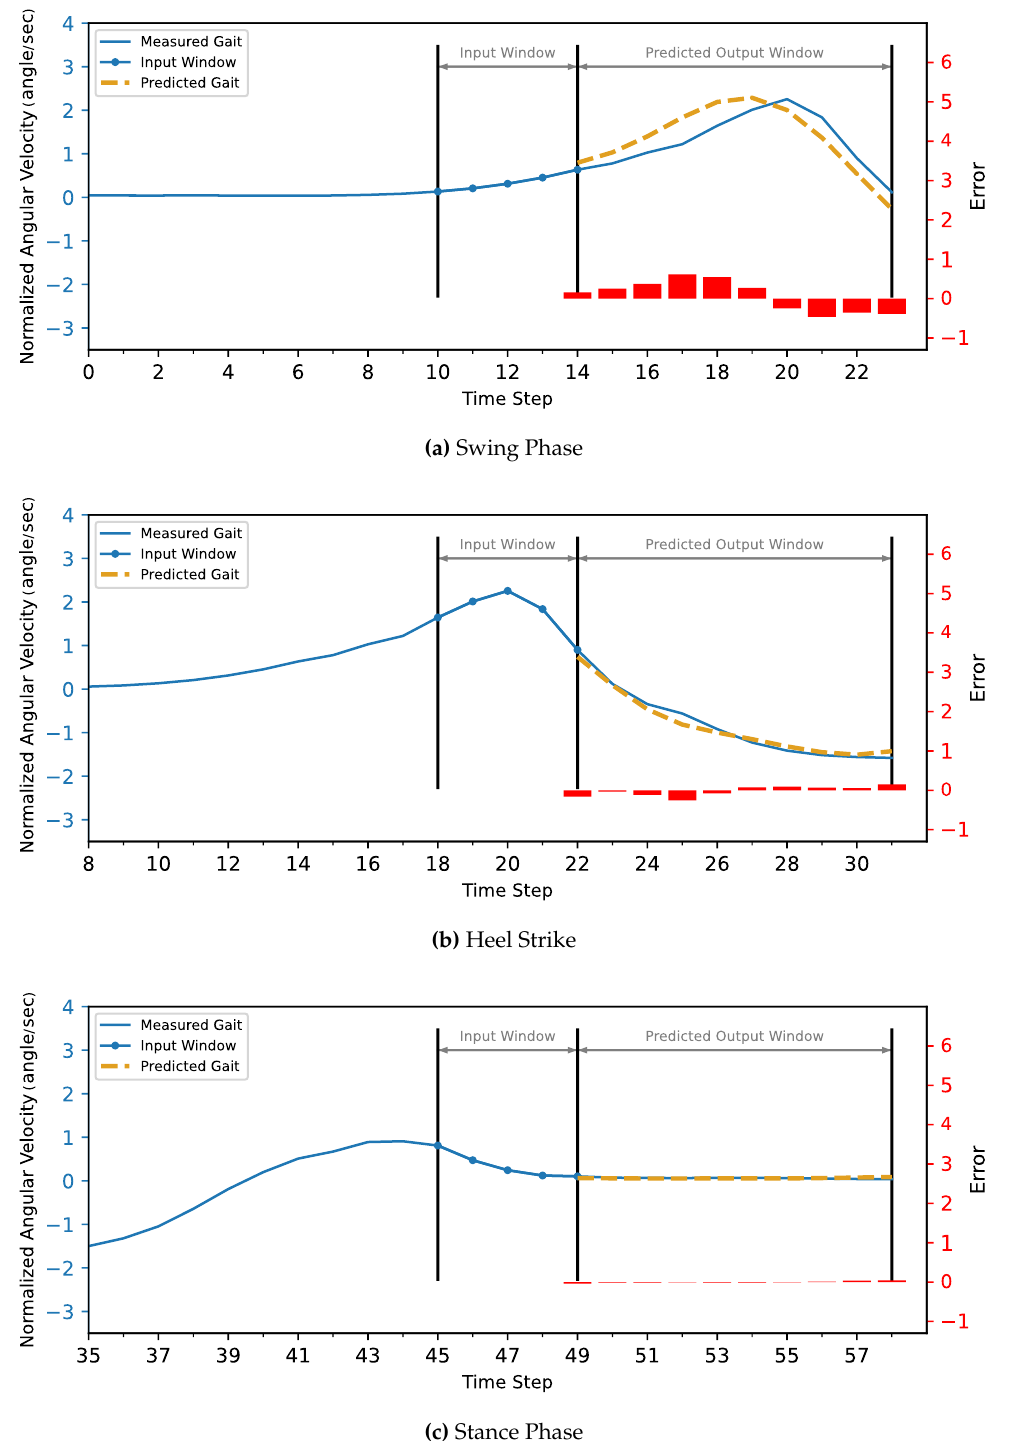
Figure 10. The CNN model with CGP 10 time steps ahead prediction for z-score normalized angular velocity of the foot of the inter-subject. The angular velocities are normalized to have zero mean and unit variance. The actual gait is shown in blue, and the predicted trajectory is shown in gold (dashed).